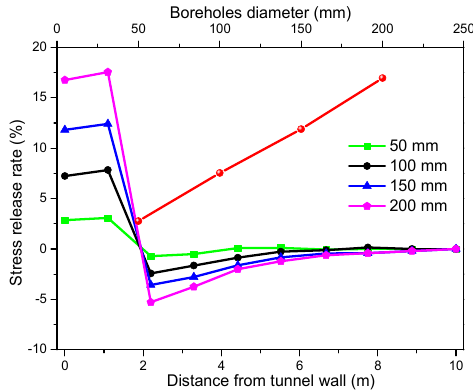
Figure 8. The effect of boreholes diameter on stress release rate. Figure 8. The e ff ect of boreholes diameter on stress release rate.